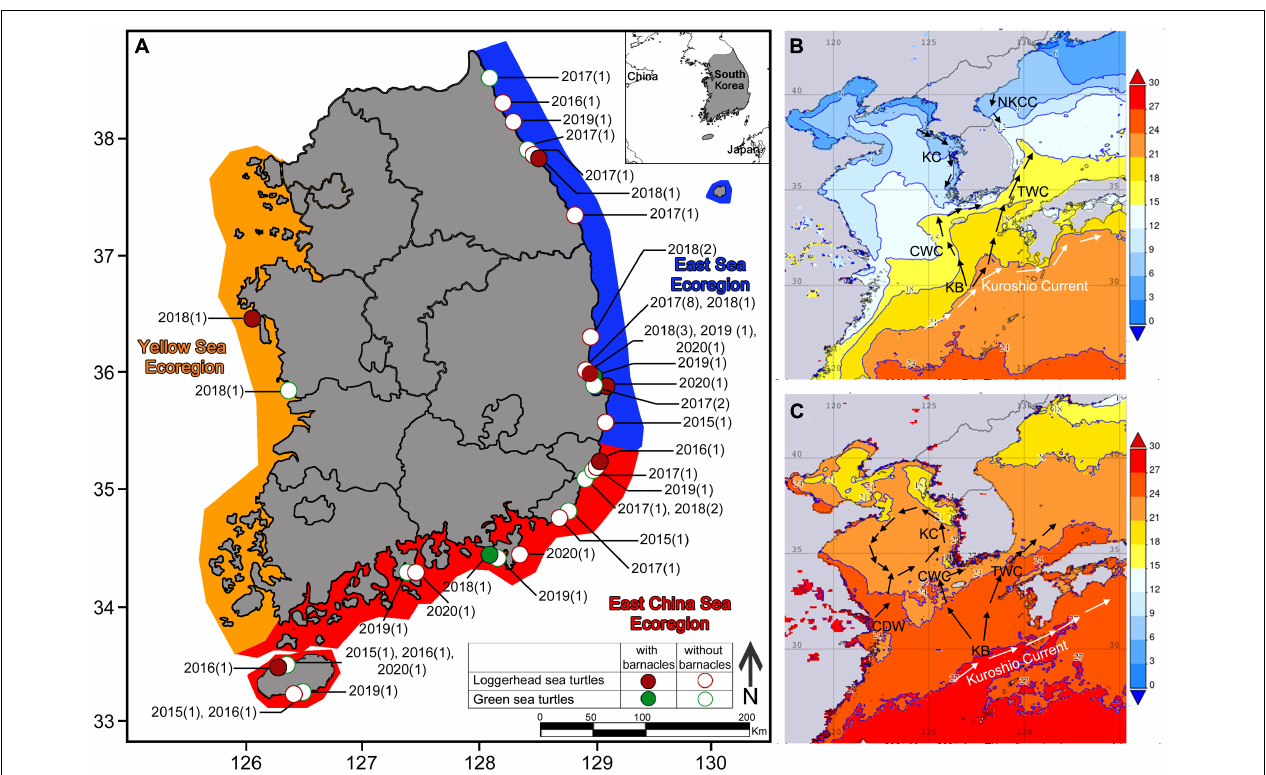
FIGURE 1 | (A) Records of stranded loggerhead and green sea turtles in Korea (Orange: Yellow Sea ecoregion, Red: East China Sea ecoregion, Blue: East Sea ecoregion). Locations of a loggerhead sea turtle with barnacles are represented by red circles. Locations of a loggerhead sea turtle without barnacles are represented by open red circles. Locations of a green sea turtle with barnacles are represented by green circles. Locations of a green sea turtle without barnacles are represented by open green circles. In each location, the year and number of strandings are stated in brackets; (B) Averaged winter surface seawater temperature (November 2020–February 2021) and oceanographic currents in Korean and adjacent waters; (C) Averaged summer surface seawater temperature (May–August 2021) and oceanographic currents in Korean and adjacent waters. Sea surface temperature map created from NASA Giovanni database version 4.36. KC, Korean Coastal Current; KB, Branch of Kuroshio Current; TWC, Tsushima Warm Current; CWC, Cheju Warm Current; CDW, Changjiang Diluted Water; NKCC, North Korean Coastal